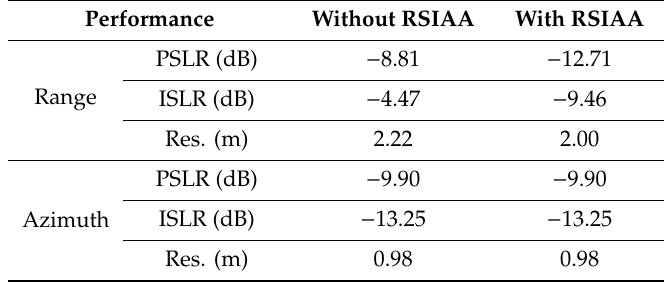
Table 9. Measured imaging performances of the point target in the marked area A.